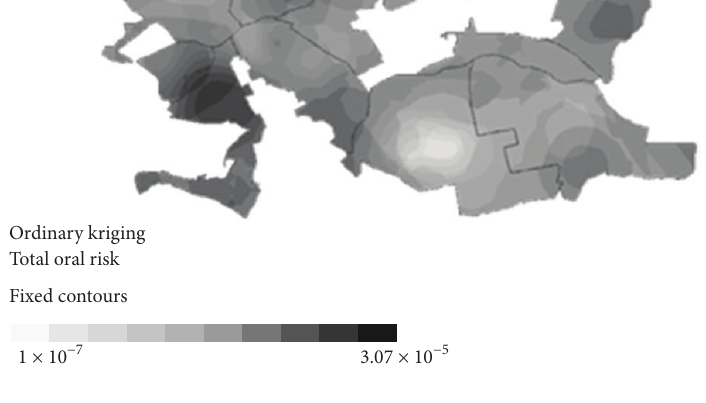
F 4: TTHM cancer risk via oral route.